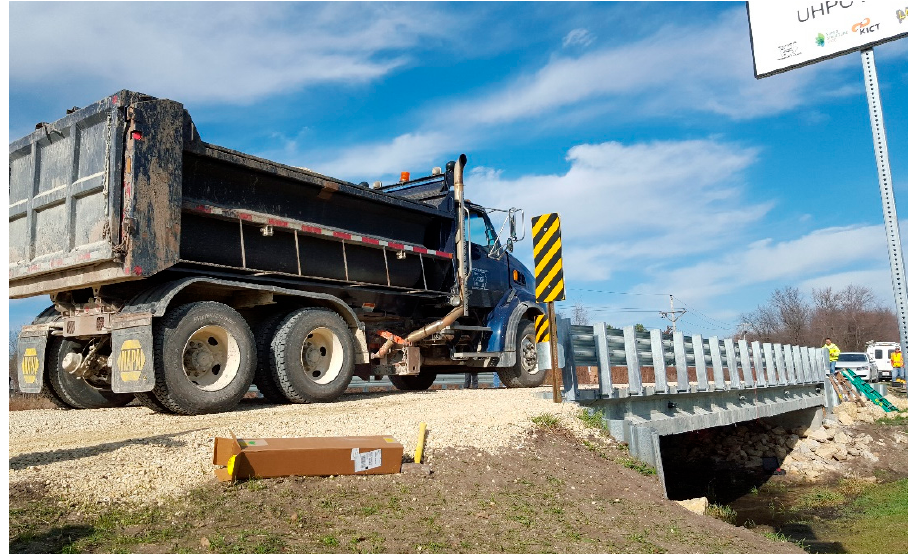
Figure 11. A heavy tandem-axial dump truck loading on bridge joints.